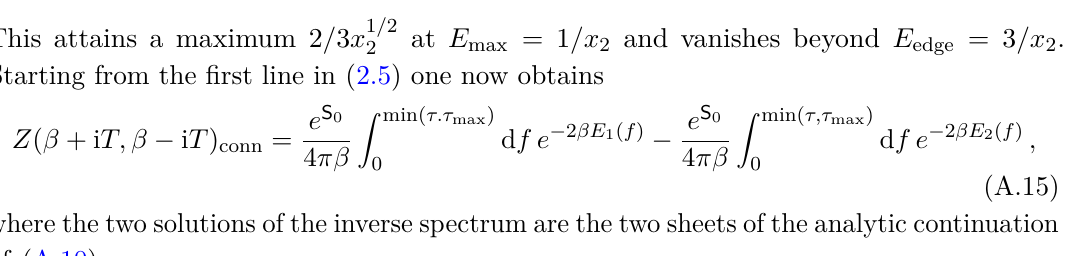
Figure 7 . For non-monotonic spectra the tau-scaled connected spectral form factor has discontinu- ities at certain points, in the case (A.15) shown here one has a discontinuity in the first derivative. In the case (A.18) relevant for black holes the discontinuity is in the second derivative, we used x 2 = 1 , e S 0 = 10 and β = 1 / 2